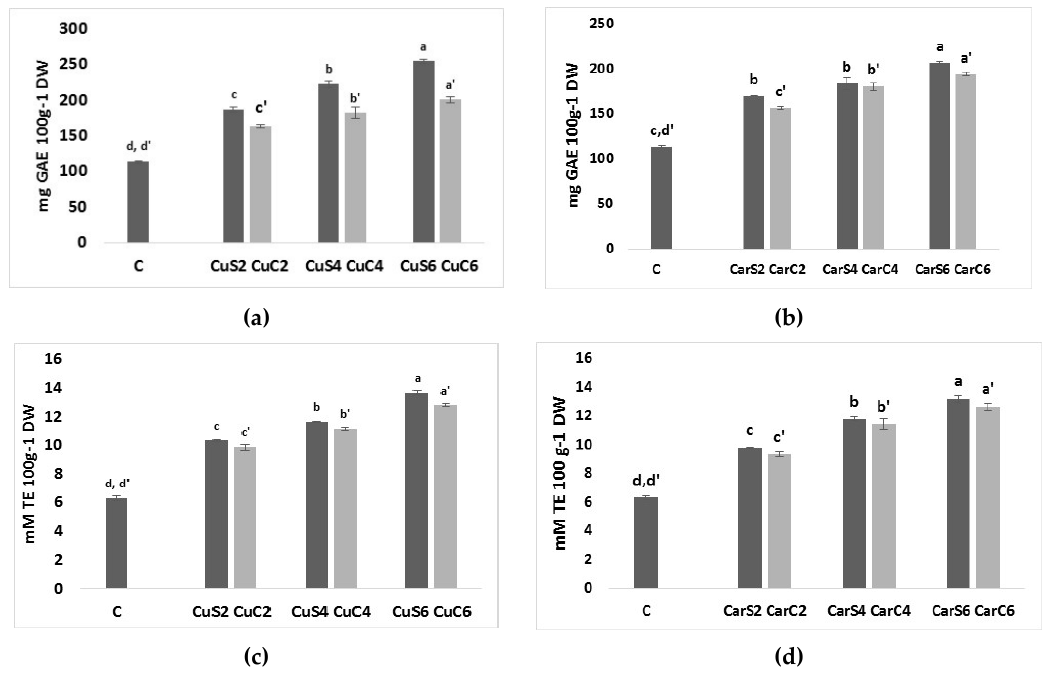
Figure 4. Total phenolic content (expressed as mg Gallic Acid Equivalent (GAE) 100 g − 1 DW (dry weight)), Trolox equivalent (TE) antioxidant capacity (TE expressed as mM TE 100 g − 1 DW) of protein bread fortified with cumin ( a and c ) and caraway ( b and d ) seeds and by-products. CuC2: 2% of cumin cake; CuC4:4% of cumin cake; CuC6: 6% of cumin cake; CuS2: 2% of cumin seed powder; CuS4: 4% of cumin seed powder; CuS6: 6% of cumin seed powder; CarC2: 2% of caraway cake; CarC4: 4% of caraway cake; CarC6: 6% of caraway cake; CarS2: 2% of caraway seed powder; CarS4: 4% of caraway seed powder; CarS6: 6% of caraway seed powder; Columns marked with the same subscript letters in each bar chart are not significantly different ( p > 0.05).